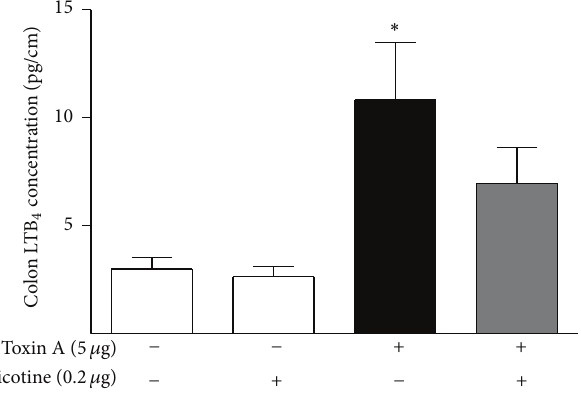
Figure 6: The effects of toxin A with and without pretreatment with nicotine on colonic LTB 4 content. Toxin A significantly stimulated colonic LTB 4 content and this effect was inhibited by pretreatment with nicotine but was not statistically significant ( 𝑃 = 0.23 ). ∗∗ 𝑃 < 0.05 versus toxin A − /nicotine − ; 𝑁 = 9